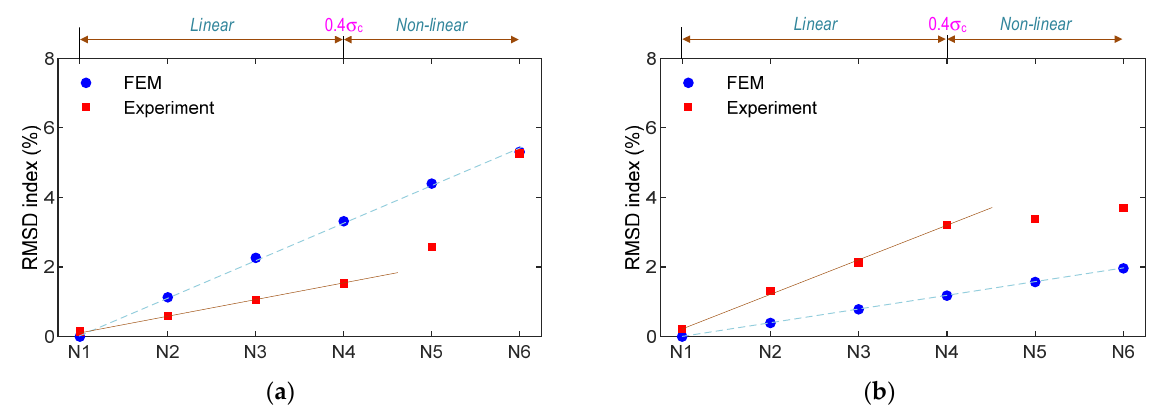
Figure 15. Comparison of numerical and experimental RMSD indices of impedance signals: ( a ) PZT-embedded smart rebar; ( b ) PZT-embedded smart aggregate.